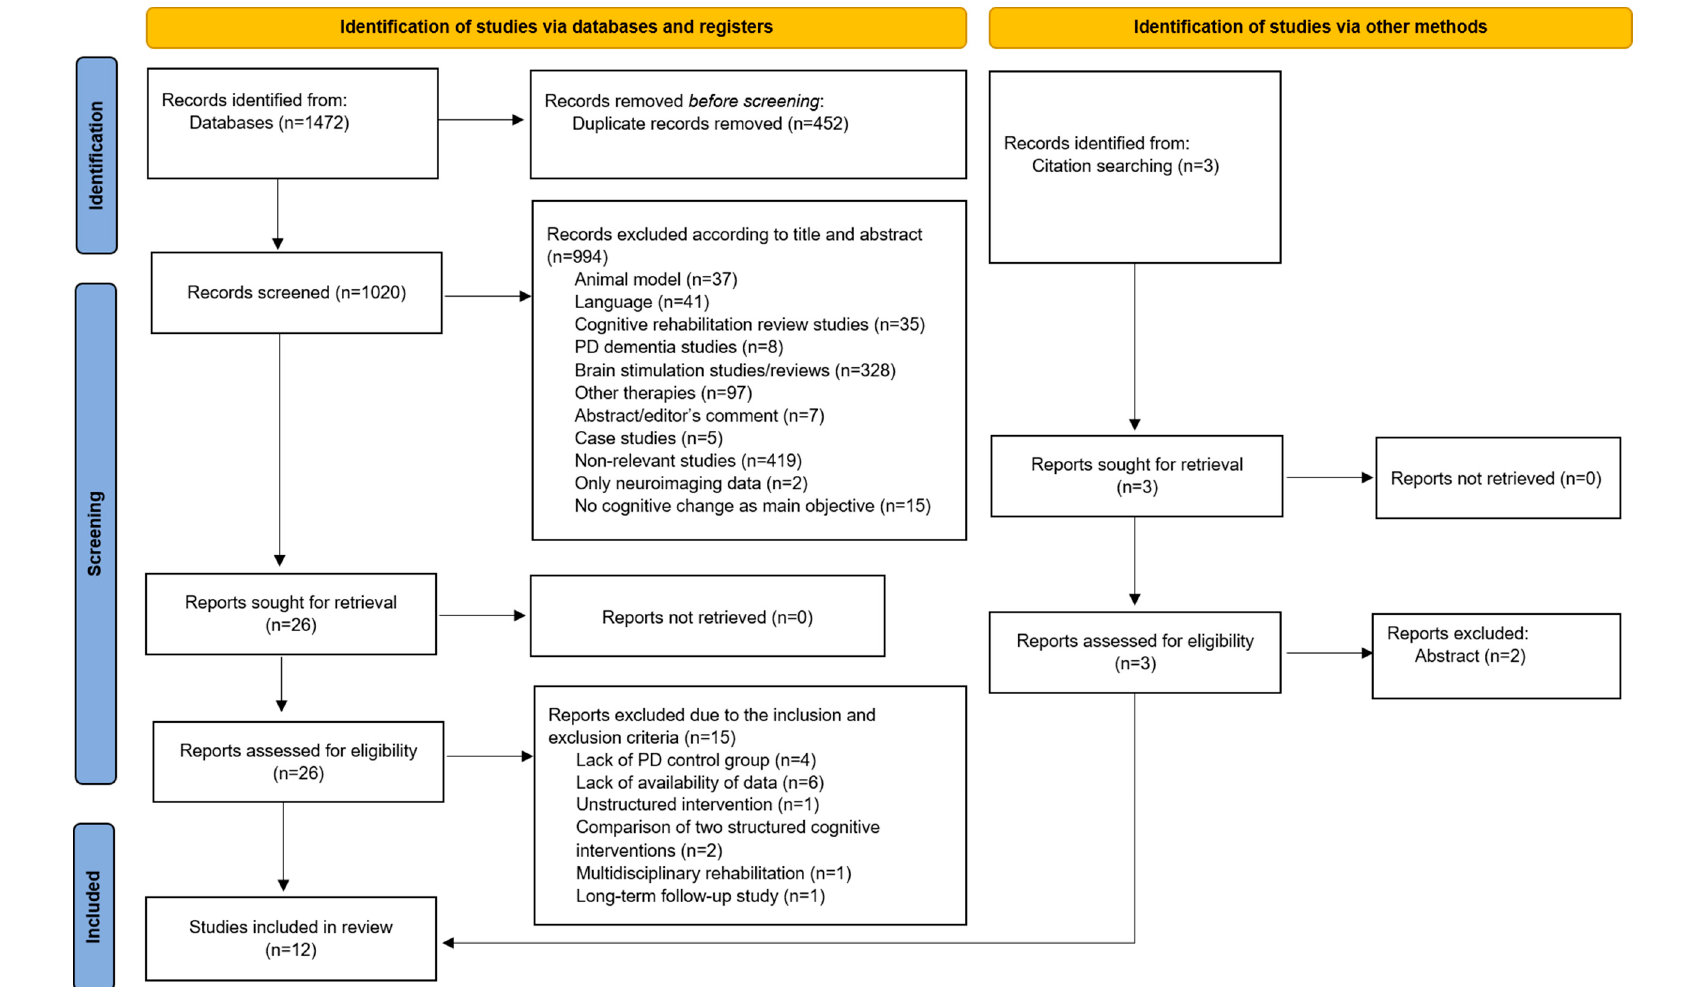
Figure 1 . PRISMA summary of identified studies included in the review. Figure 1. PRISMA summary of identified studies included in the